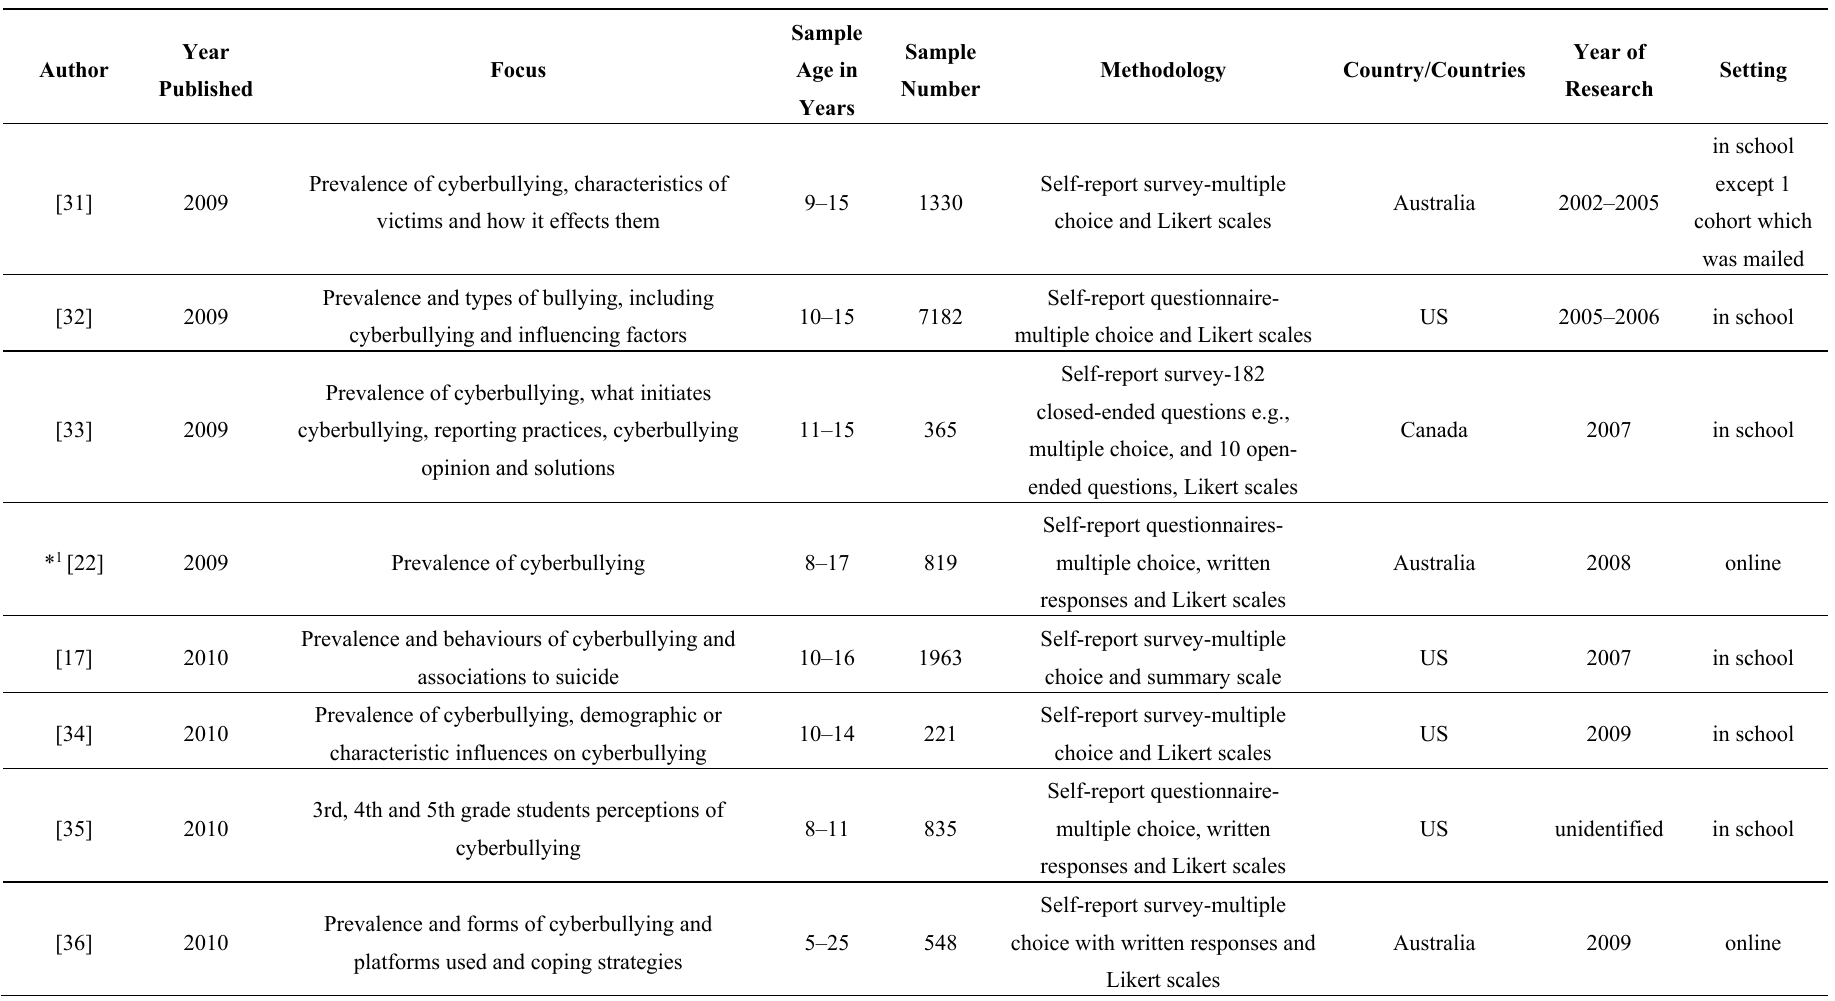
Table 2. Overview of recent research on cyberbullying prevalence, understandings, behaviours and impacts with children aged 5–12 years.